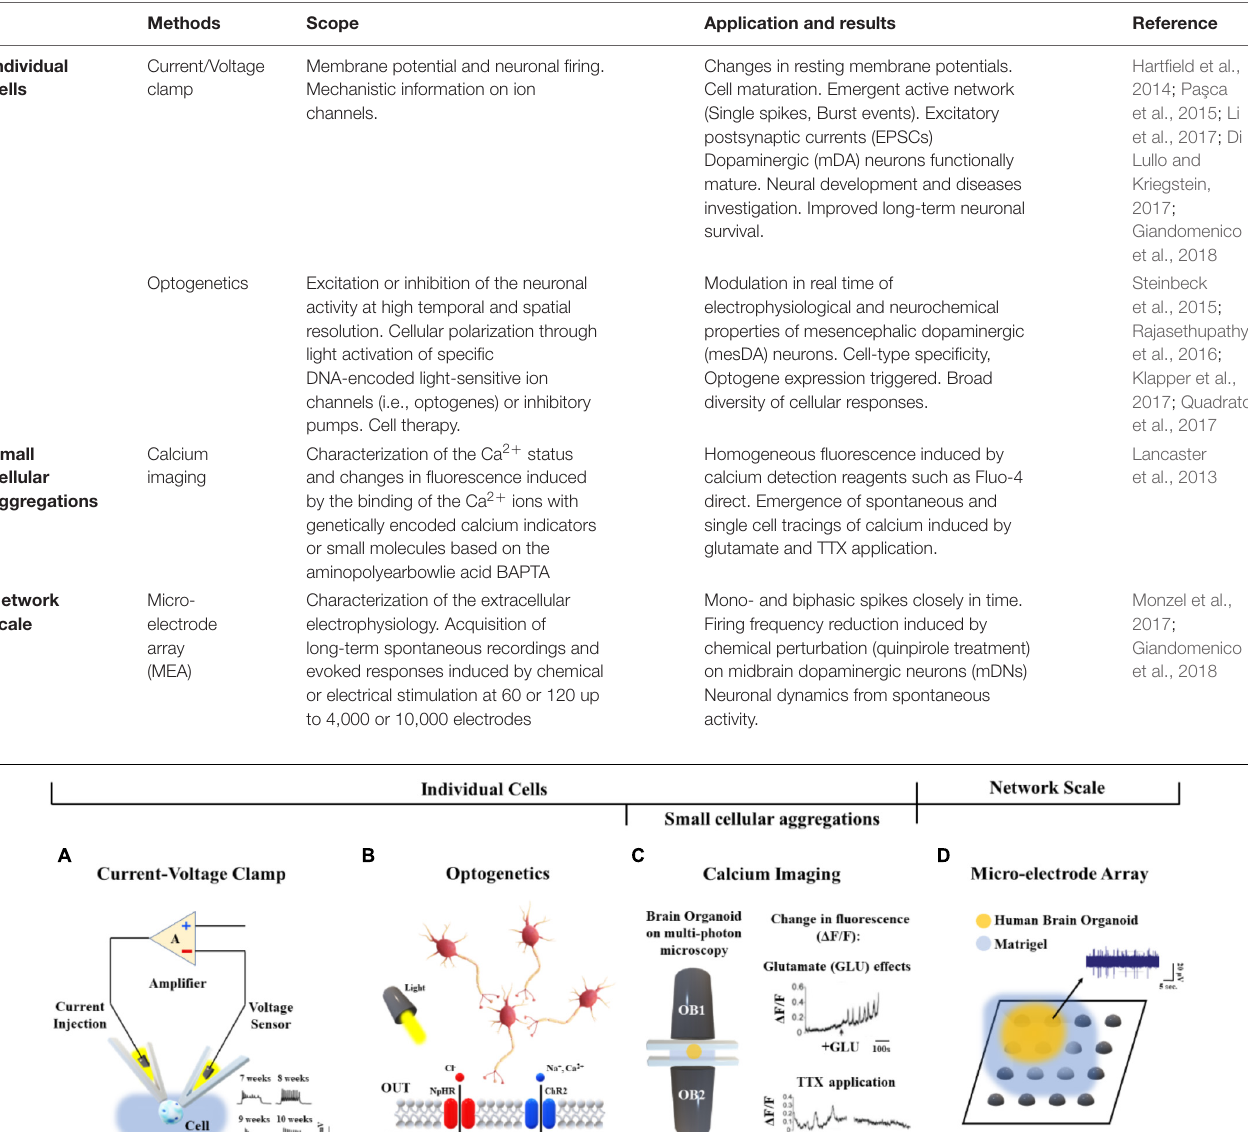
TABLE 2 | Electrophysiological approaches adapted to functionally characterize brain organoids: The state-of-art. Methods